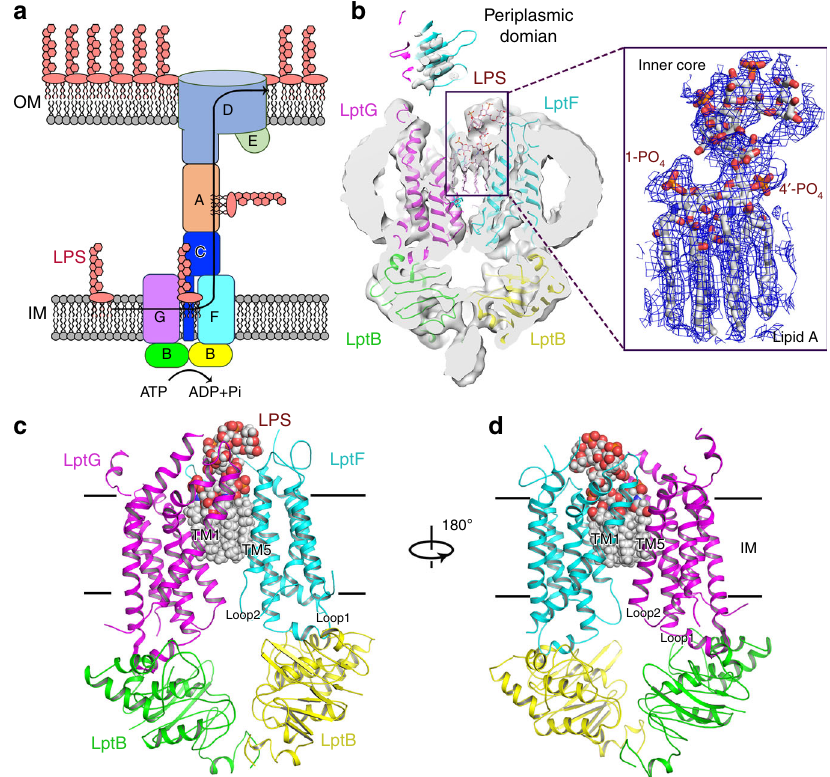
Fig. 1 Architecture of LPS-bound sf LptB 2 FG complex. a A scheme of seven lipopolysaccharide transport proteins form a trans -envelope bridge to transport LPS from the IM to the OM. b Left panel: a cross-sectional view of cryo-EM map of LPS-bound sf LptB 2 FG; Right panel: a closed view of LPS. A clear density for LPS is shown in blue mesh and LPS is shown in stick. LptF, LptG and the two LptB molecules are presented in cartoon and coloured in cyan, purple, green and yellow, respectively. c Cartoon representation of LPS-bound sf LptB 2 FG. An LPS molecule, shown in spheres, is located in the upper cavity of the transmembrane channel. d Rotation of 180° along the y -axis relative to